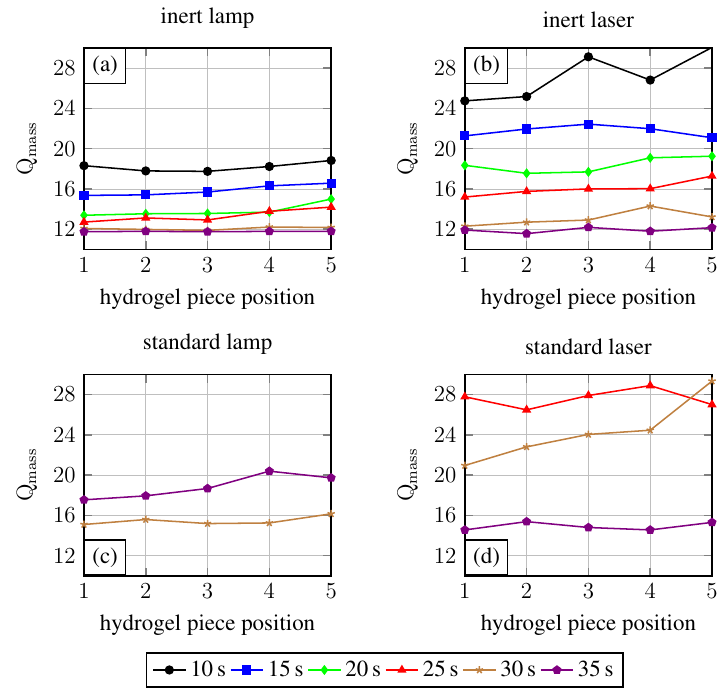
Figure 5. Localised resolution of the polymerisation process. The primary gel were cut into five pieces per body and the degrees of swelling were measured.